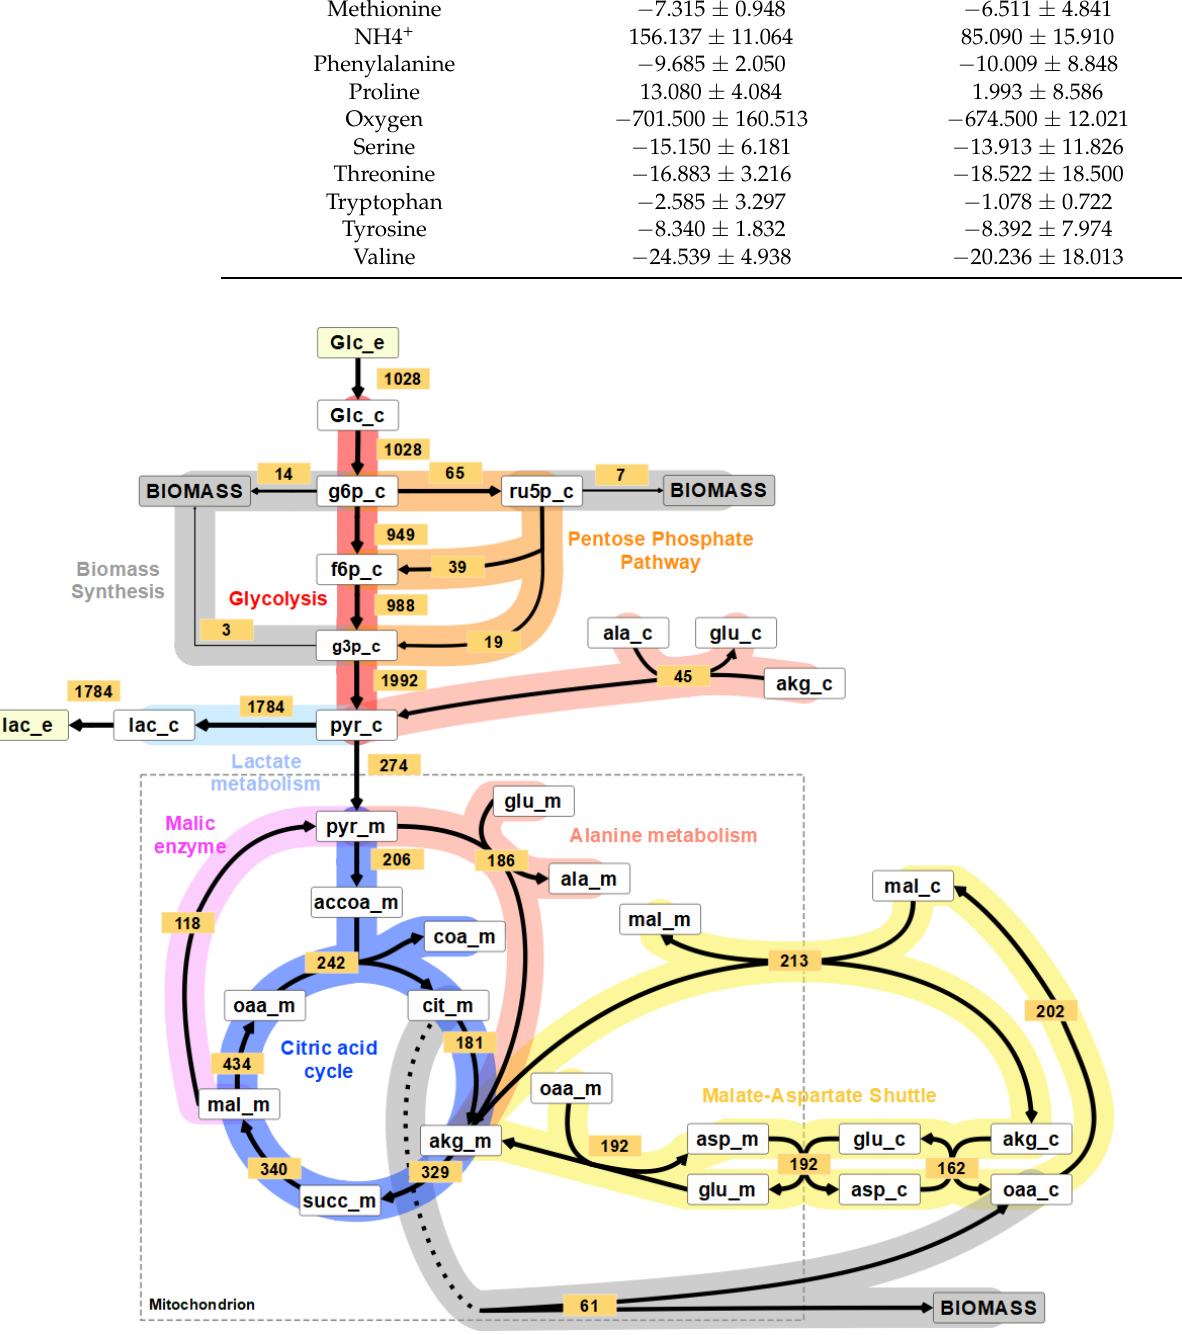
Figure 4. Metabolic flux distribution of the parental KB26.5 hybridoma cell line. The arrows indicate the direction of the reaction; the arrow thickness is proportional to the flux rate. Different coloring was used for each pathway, and the model was structured in cytoplasmic and mitochondrial reactions (mitochondrion is limited by a discontinued line). The values in the boxes correspond to the flux rate in nmol metabolite/(mg DCW·h).